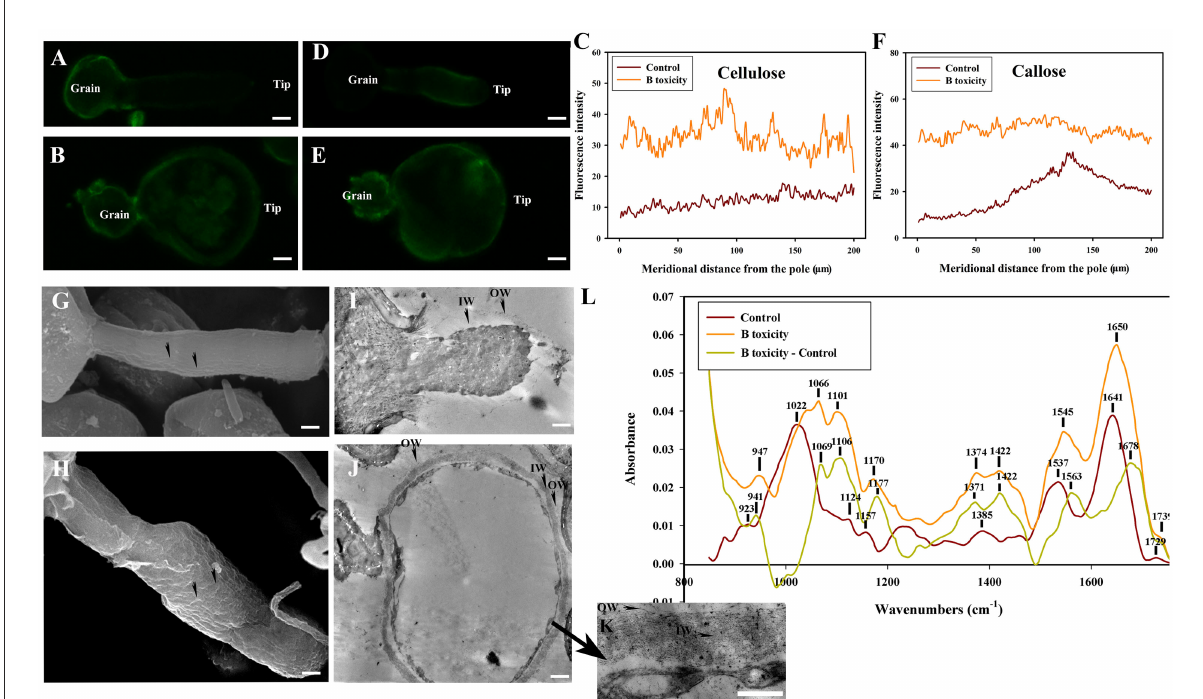
FIGURE7 Effects of B toxicity on cell wall architecture with pectinase treatment. (A) Cellulose in control pollen tube digested with pectinase indicated by CBM3a labeling. (B) Cellulose in B toxicity-treated pollen tube digested with pectinase. (C) Quantitative analysis of the fluorescent intensity of cellulose in the wall of control (Control) and B toxicity-treated pollen tubes which were digested with pectinase. (D) Callose in control pollen tube indicated by monoclonal antibody to (1 → 3)- β -glucan labeling digested with pectinase. (E) Callose in B toxicity-treated pollen tube treated with pectinase. (F) Quantitative analysis of callose fluorescent intensity in the wall of control (Control) and B toxicity-treated pollen tubes which were digested with pectinase. (G) SEM of control pollen tube digested with pectinase. (H) SEM of B toxicity-treated pollen tube digested with pectinase. (I) TEM transverse section of control pollen tube digested with pectinase. After pectinase treatment, the fibrous pectic layer reduced substantially, only a small number of fibres exited in OW, and the callose layer was difficult to be observed. (J,K) TEM transverse section of B toxicity-treated pollen tube digested with pectinase. A small number of fibers were observed in OW, but the IW of B toxicity-treated pollen tubes was thick, and much more fibers were crosslinked with the callose layer. (L) FTIR spectra from the tip regions of C . mollissima pollen tubes digested with pectinase (control pollen tube: Control), B toxicity-treated pollen tubes digested with pectinase and the FTIR differential spectrum (B toxicity – control) generated by digital subtraction of the control spectra from B toxicity-treated spectra digested with pectinase. Bar = 10 µ m in (A,B,D,E) . Bar = 3 µ m in (G,H) ; Bar = 2 µ m in (I,J) . Bar = 1 µ m in (K) . OW, Outer wall; IW, inner wall. The arrows indicated the strip protuberances (G) and wave protuberances (H)